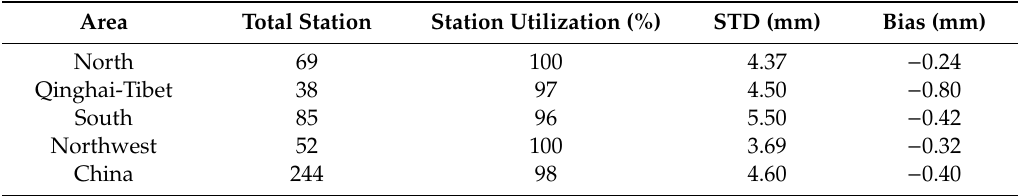
Figure 4. STD and bias distributions of GNSS-derived ZTD differences using GAMIT/GLOBK and PANDA software during the period 2011–2017. Table 4. Statistical results of STD and bias, as well as the number of RS stations, in the four regions of China during the period 2011–2017.